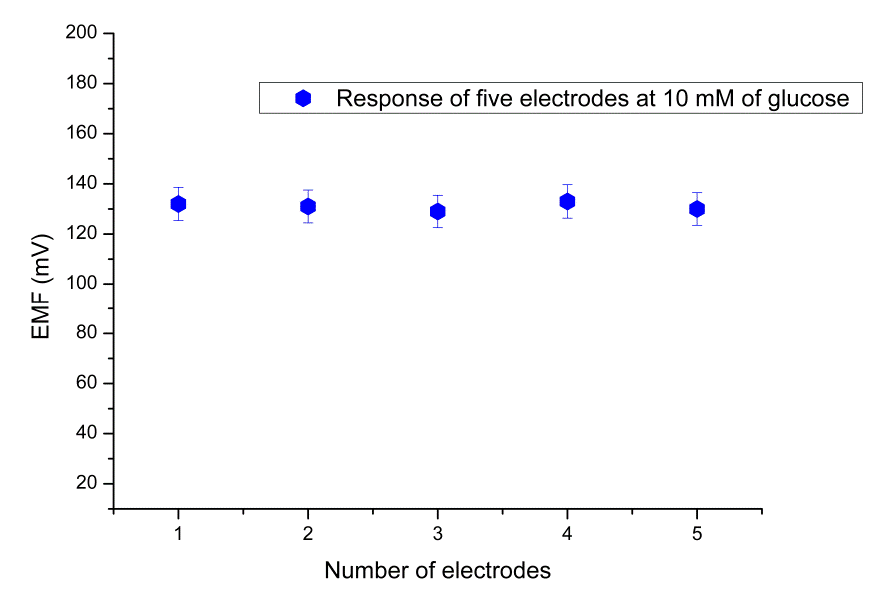
Figure 9. Reproducibility of the sensor